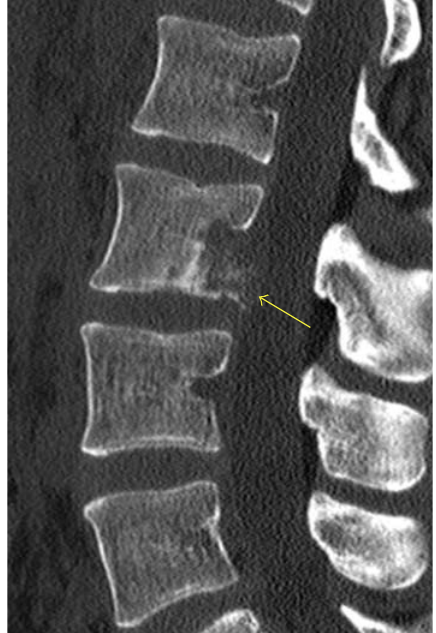
Figure 3: Sagittal CT reformation in bone algorithm depicts a corti- cal break in the posterior cortex of the L3 vertebral body (yellow arrow) due to a metastatic focus.